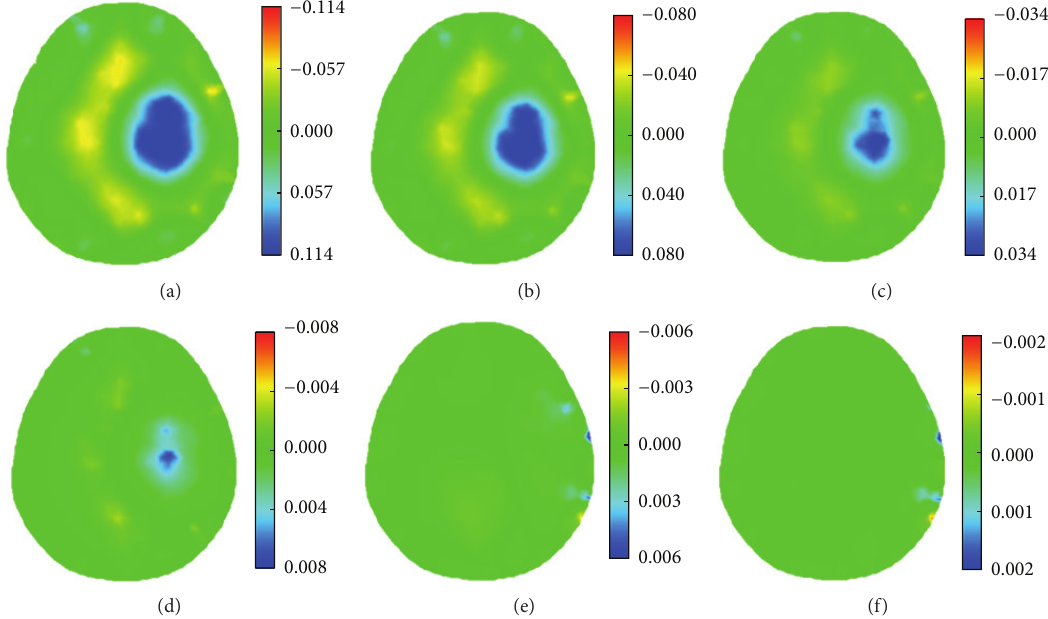
Figure 17: SEIT reconstructions of the simulated ischemic stroke lesions of different sizes. Images (a) to (f) are SEIT reconstructions corresponding to the simulated ischemic stroke lesion with a radius of 2.00, 1.50, 1.00, 0.50, 0.25, and 0.10cm, respectively.